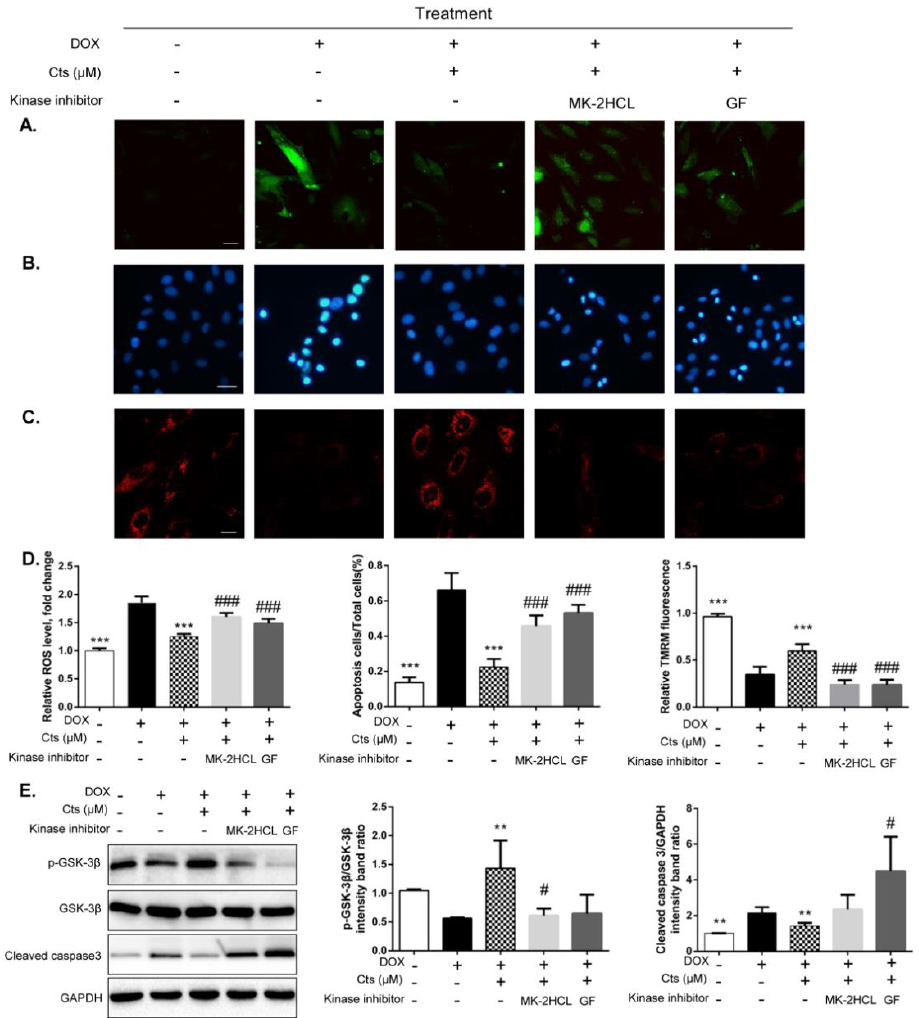
Figure 4. Cts protected against Dox-induced mitochondrial injury via the AKT-GSK- 3β signaling pathway. ( A ) Accumulation of H 2 O 2 in H9C2 cells was detected by probes DCFH2-DA. MK-2HCL abolished the inhibitory effect of Cts on H 2 O 2 . Scale bar, 50 μm. ( B ) Hoechst 33342 staining showed that MK-2HCL abolished the effect of Cts on apoptosis. Scale bar, 20 μm. ( C ) TMRM sequestration assays showed that MK-2HCL abolished the protective effect of Cts on MMP. Scale bar, 50 μm. ( D ) Quantification of fluorescence including DCFH-DA, apoptotic cells and TMRM. Fluorescence intensity was determined by Image J software. Results were presented as means ± SD ( n = 3 repeated experiments, 15 cells per group). *** p < 0.001 vs. Dox-treatment group, ### p < 0.001 vs. Cts-treatment group. ( E ) Western blot showed that the effects of Cts on p-AKT and p-GSK- 3β were significantly abolished by Akt inhibitor. Results were presented as means ± SD from independent experiments performed in triplicate. * p < 0.05, ** p < 0.01 vs. Dox-treatment group, # p < 0.05, ## p < 0.01 vs. Cts-treatment group.